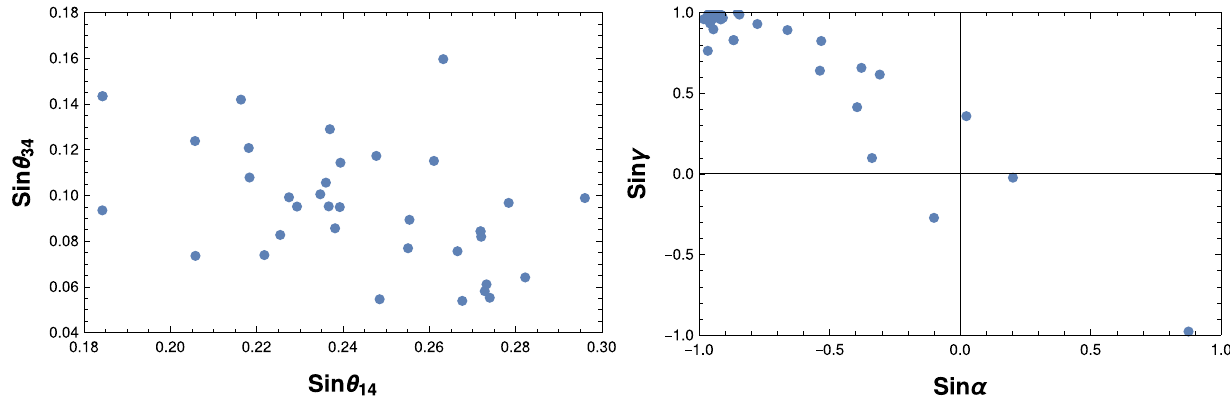
Fig. 1 Neutrino oscillation parameters in active-sterile sector for case (ii) from μ – τ symmetric category for NH